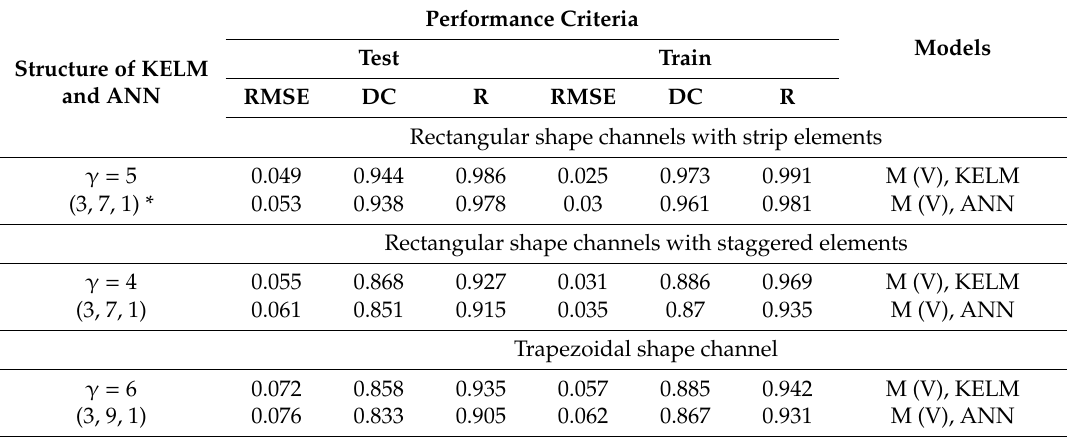
Table 5. Statistical parameters of the KELM and Artificial Neural Network (ANN) methods for the superior models.